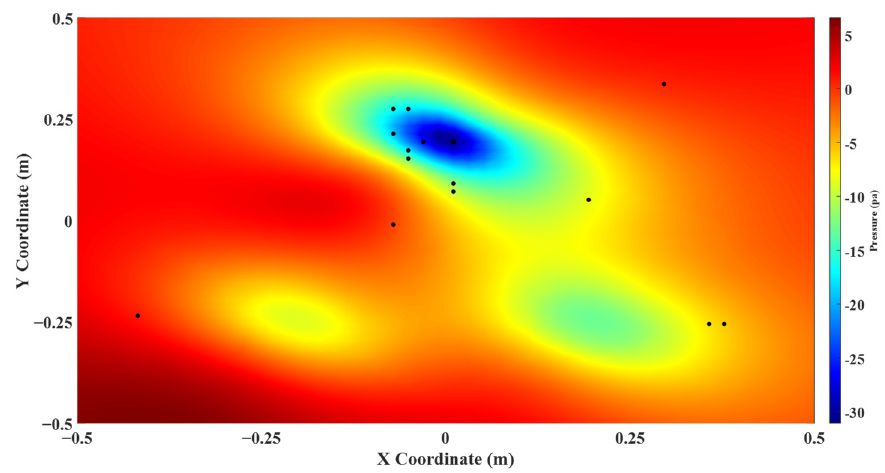
Figure 26. Reconstructed pressure nephogram (boundary condition 2) of the first plane with fifteen sensor positions (black points).